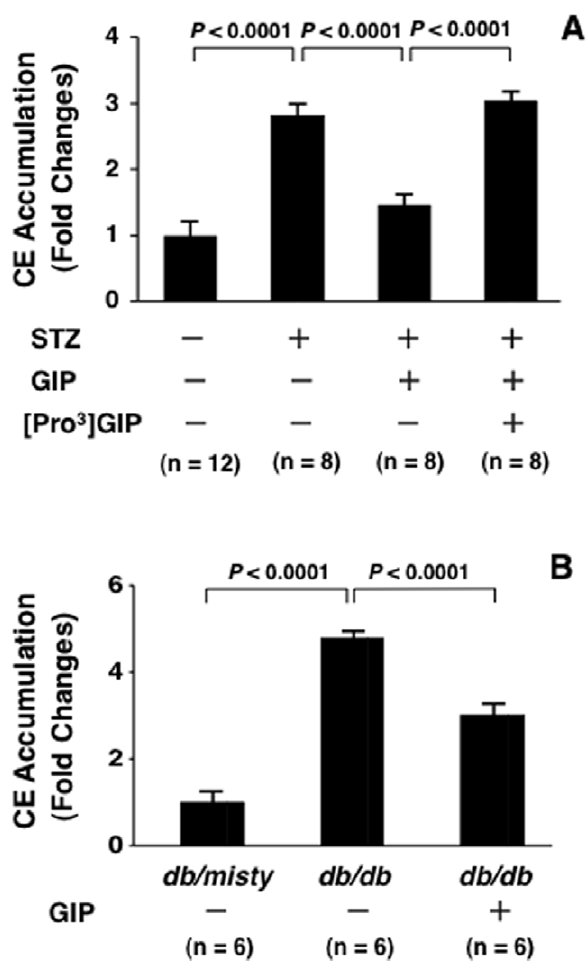
Figure 2. Foam cell formation in exudate peritoneal mouse macrophages. A , 12 Apoe 2 / 2 mice at 15 weeks of age were made diabetes by peritoneal injection of STZ (50 mg/kg/day) for 5 days and 6 Apoe 2 / 2 mice were untreated. The 17-week-old diabetic Apoe 2 / 2 mice were infused for 4 weeks with vehicle, GIP (25 nmol/kg/day), or GIP + [Pro 3 ]GIP (both 25 nmol/kg/day) by osmotic mini-pumps. B , 6 db/ misty mice and 6 db/db mice at 8 weeks of age were started to be infused with saline and 6 db/db mice were ifused with GIP (25 nmol/kg/ day). Four weeks after infusions, exudate peritoneal macrophages were obtained from these mice by intraperitoneal injection of thioglycolate, and incubated with oxLDL (10 m g/ml) for 18 hours. Foam cell formation was evaluated by oxLDL-induced CE accumulation in macrophages. Assays were performed in duplicate or single. 1 fold=17.5 6 1.0 nmol/ mg cell protein (A) and 14.7 6 1.2 nmol/mg cell protein